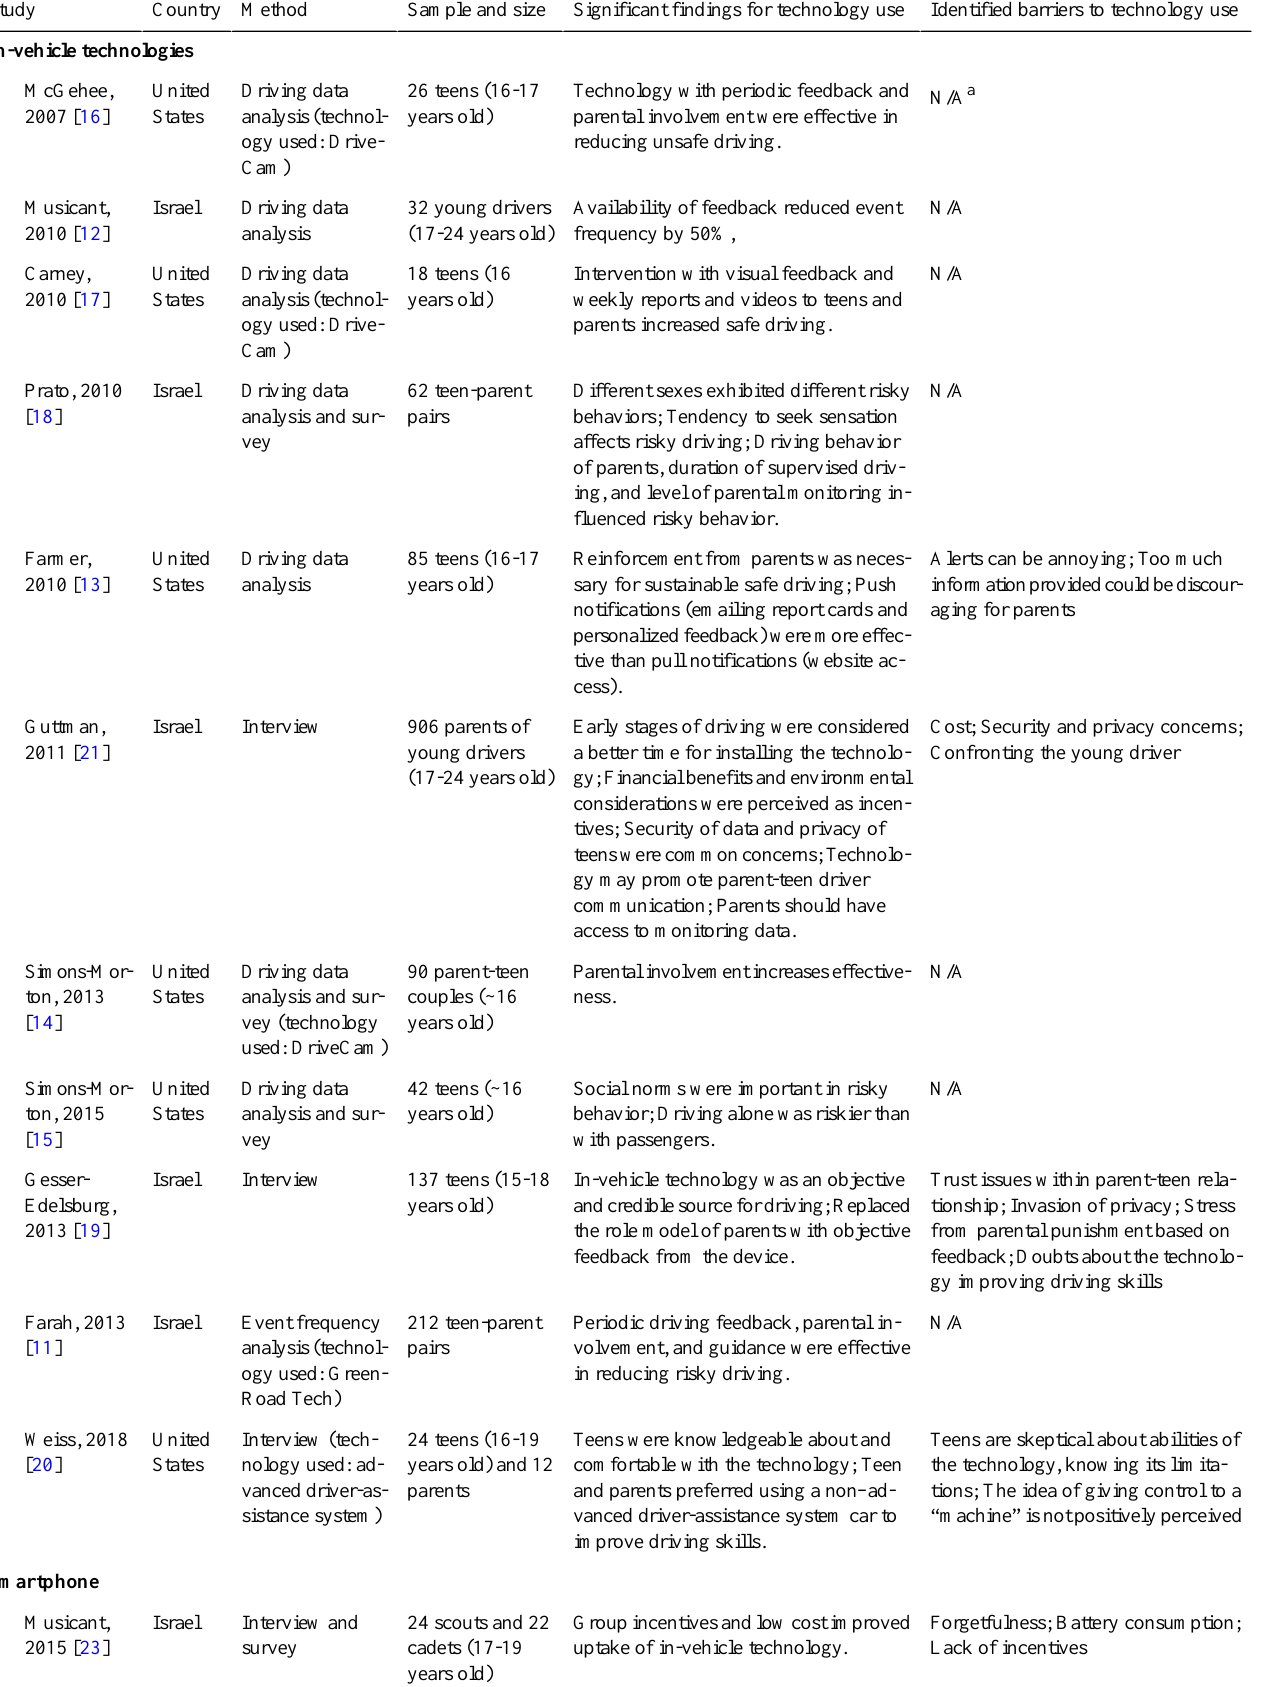
Table 2. Literature summary grouped by the type of technology used.